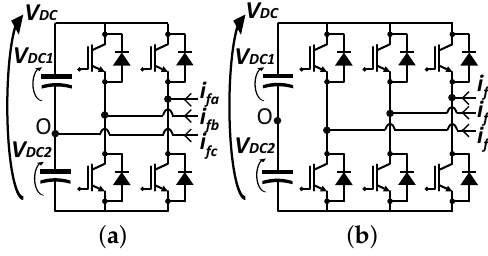
Figure 2. Detailed GSC structure. ( a ) 2L2B proposed; ( b ) 2L3B